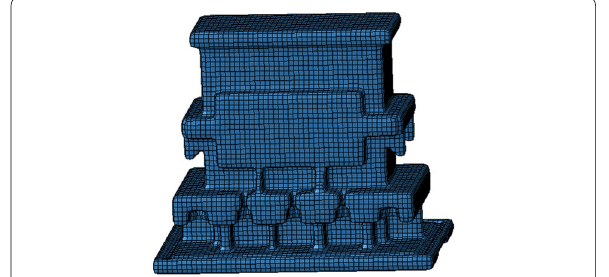
Figure 4 BEM model